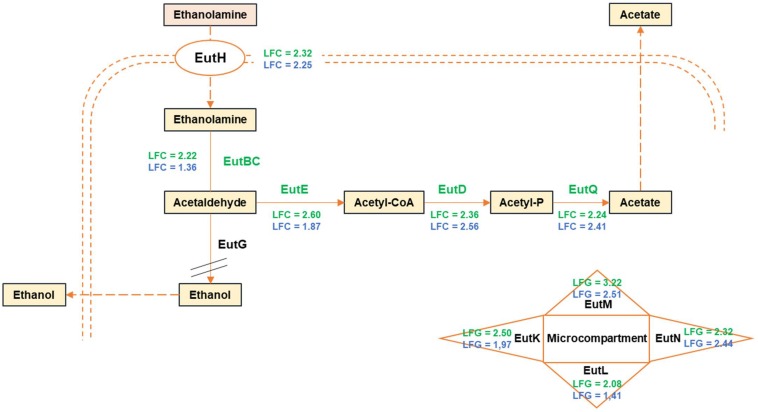
Proposed pathway of ethanolamine utilization by B. thermosphacta strains CD 337 and TAP 175 in meat juice. LFC values were represented with a color code depending on strain: CD 337 (green); TAP 175 (blue). The gene encoding EutG was downregulated in meat juice. EutKLMN form a micro compartment encasing the enzymes necessary for ethanolamine catabolism.